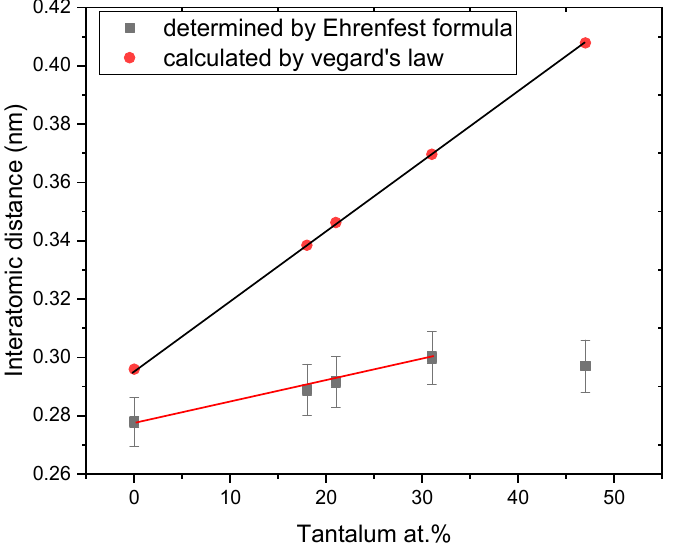
Figure 3. Evolution as a function of the tantalum content of the mean distance between the first neighbors determined by Ehrenfest formula and calculated by Vegard’s law.